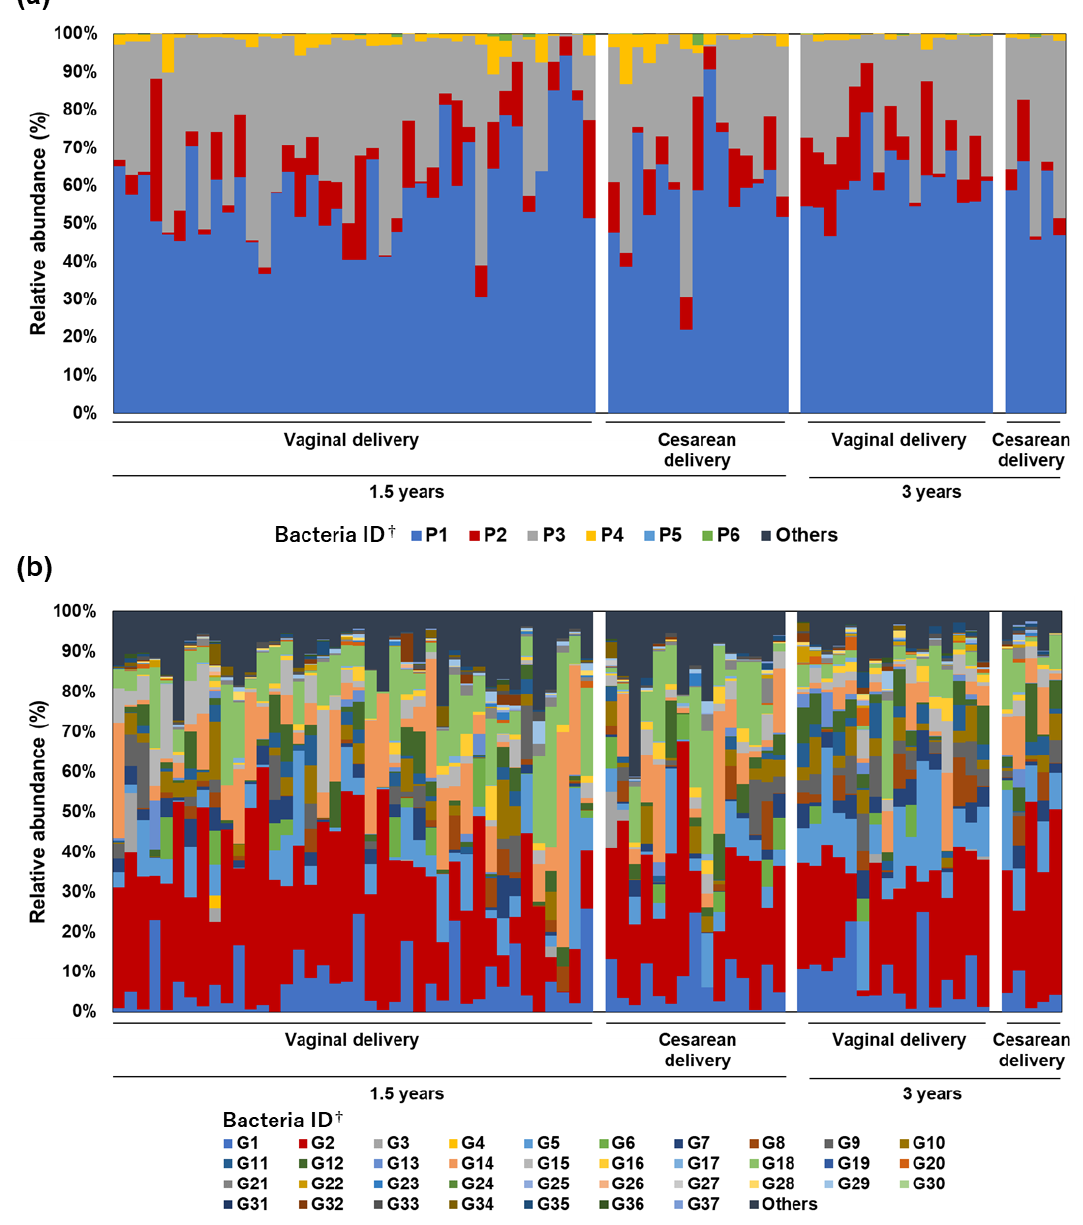
Figure 7. Research II : Fecal bacterial composition at the phylum and genus levels in 76 toddlers. ( a ) Phylum and ( b ) genus levels. Bacteria detected at less than 1% of their relative abundance were grouped together as Others. These were sorted by age and mode of delivery. † See Table S1 or Table S5 for the bacterial taxonomy name corresponding to each ID. Table 4. Diversity indices of the adult and toddler gut microbiota.